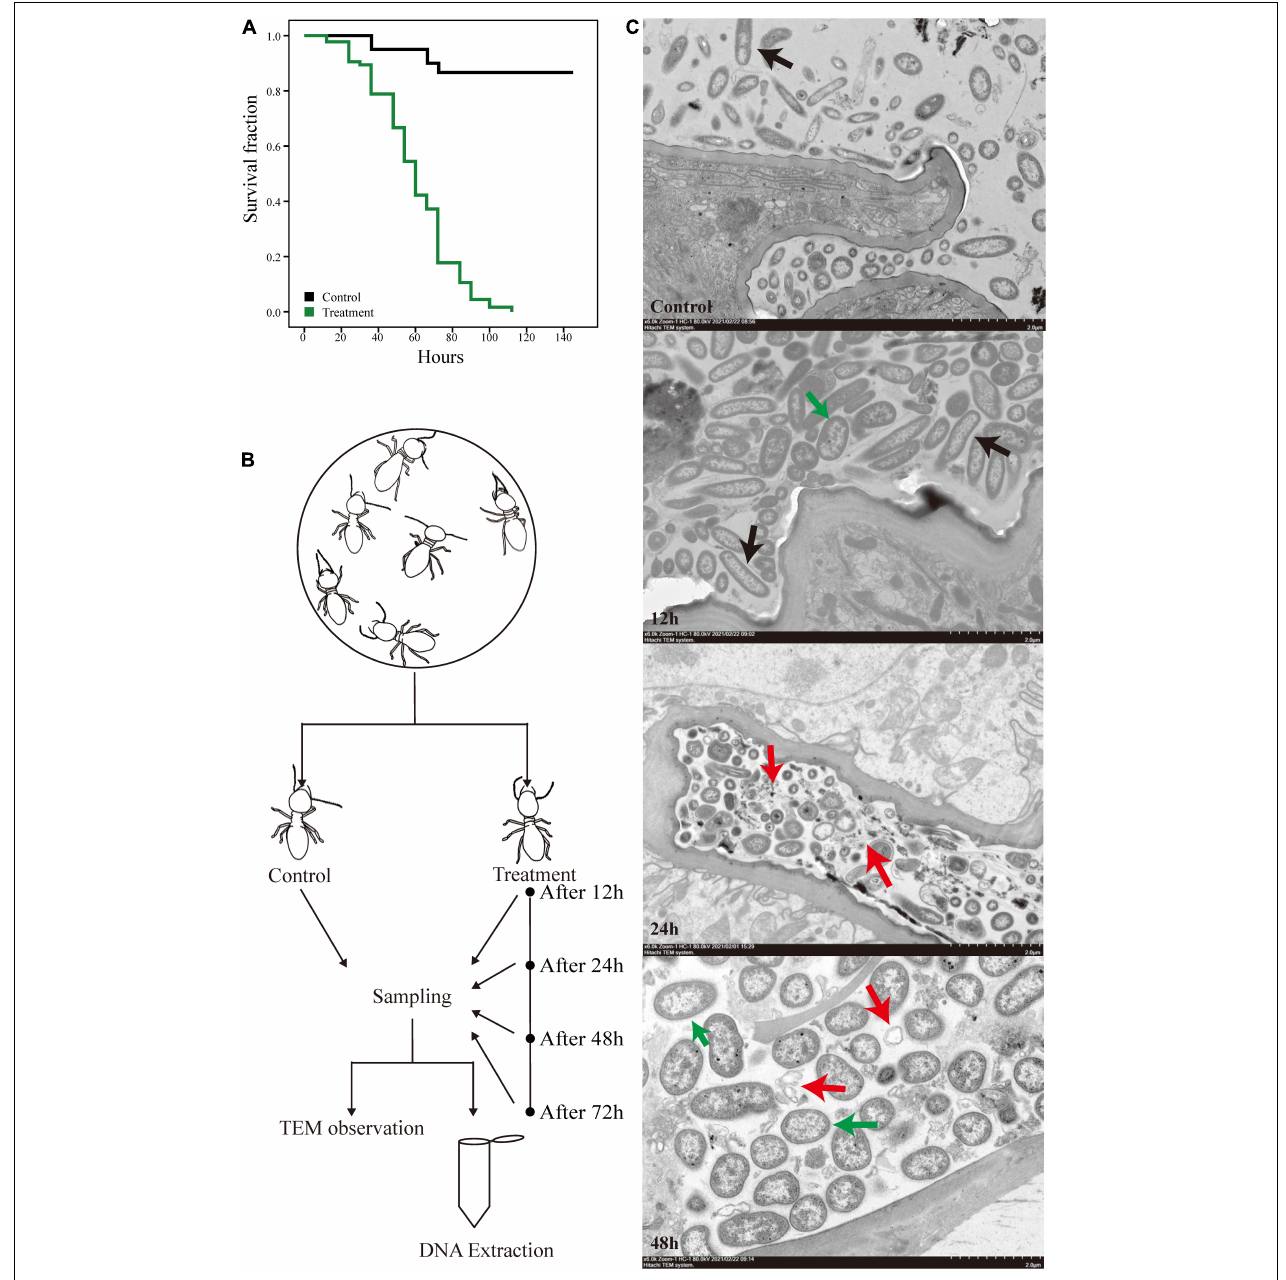
FIGURE 1 | Experimental design and the survival curves of O. formosanus during M. robertsii infection. (A) Kaplan–Meier survival curve of fungus treatment and control groups. (B) Experimental design. (C) Transmission electron microscopy (TEM) images of the hindguts of individuals from treatment groups after 12, 24, and 48 h of M. robertsii infection, in addition to those of individuals from uninfected control groups. All images were captured from a HITACHI transmission electron microscope (Model HT7800; scale bar: 2 µ m). Black arrows: gut microorganisms in the form of long strips or pikes; red arrows: microorganism lysis debris; green arrows: M. robertsii